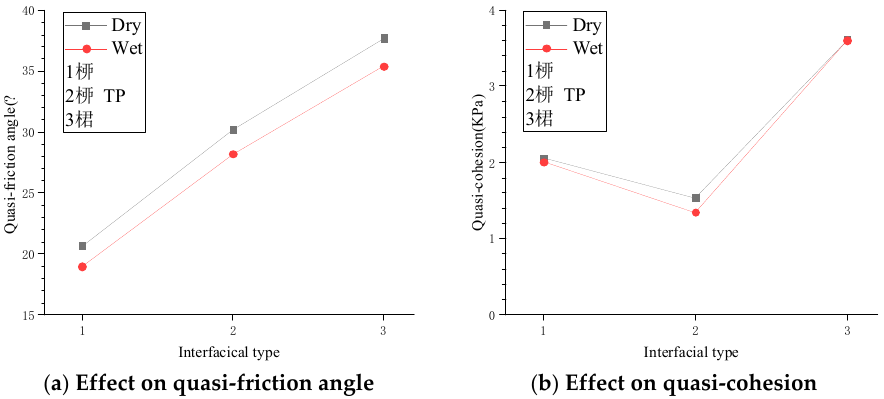
Figure 11. Effects of the interfacial type and dry – wet state on the interfacial shear strength indexes. For P-type, PTP-type, and T-type interfaces in the dry state, the quasi-friction angles were 20.616 , 30.22 , and 37.704 , respectively, while they were 18.968 , 28.191 , and 35.393 in the wet state. The wet interface decreased the quasi-friction angles by 8.0%, 6.7%, and 6.1% for the three interfaces above, respectively. The e ff ect of the wet state on the quasi-friction angle in the P-type interface was slightly larger than the others. Compared with P-type and PTP-type interfaces, in the dry state, the quasi-friction angle of the T-type interface increased by 82.9% and 24.8%, while in the wet state it increased by 86.6% and 25.5%. It was revealed that although the quasi-friction angle varied with both the interfacial